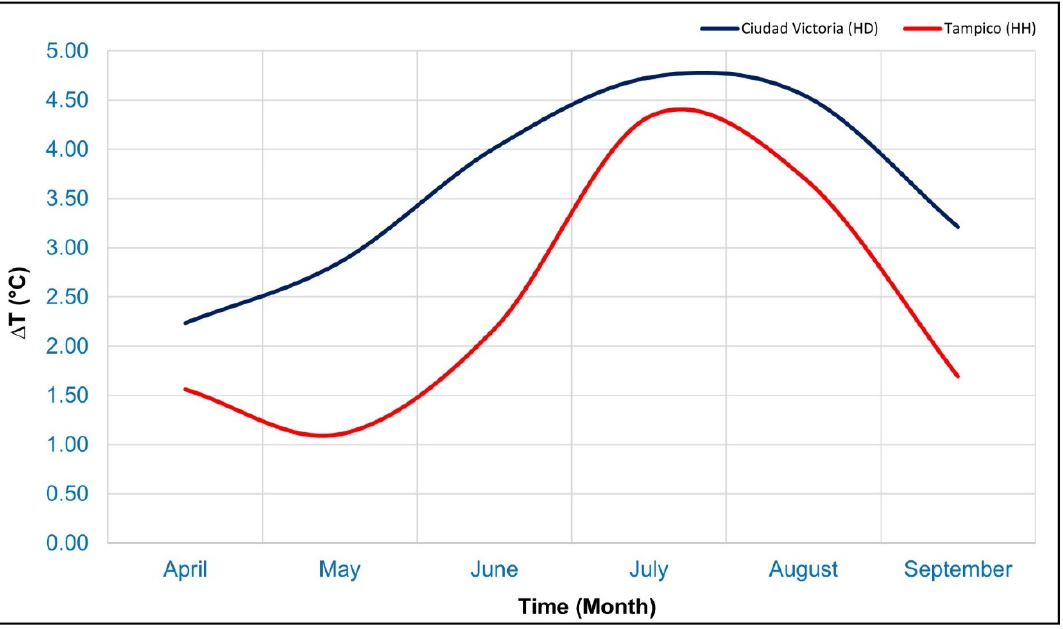
Figure 8. Comparison of the thermal comfort requirement in HD and HH climates.